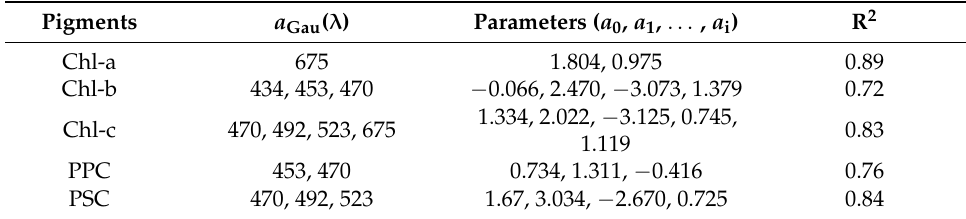
Table 4. Parameters for estimation of pigment concentrations: the pigment-specific a Gau ( λ ), coefficients and R 2 . Chl-a: chlorophyll a , Chl-b: chlorophyll b , Chl-c: chlorophyll c , PPC: photo-protective carotenoids, PSC: photosynthetic carotenoids.